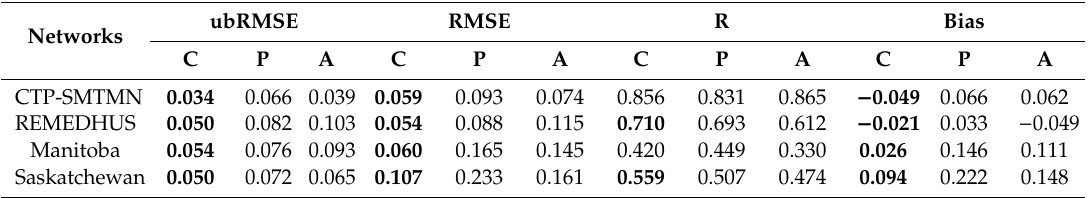
Table 1. The unbiased root mean square error (ubRMSE), root mean square error (RMSE), Pearson correlation coe ffi cient (R) and bias of the comparison between the in-situ SM (AM) with the active (A), passive (P) and combined (C) CCI SM product for CTP-SMTMN, REMEDHUS and RISMA (Manitoba, Saskatchewan). Bold numbers indicate that the combined products perform